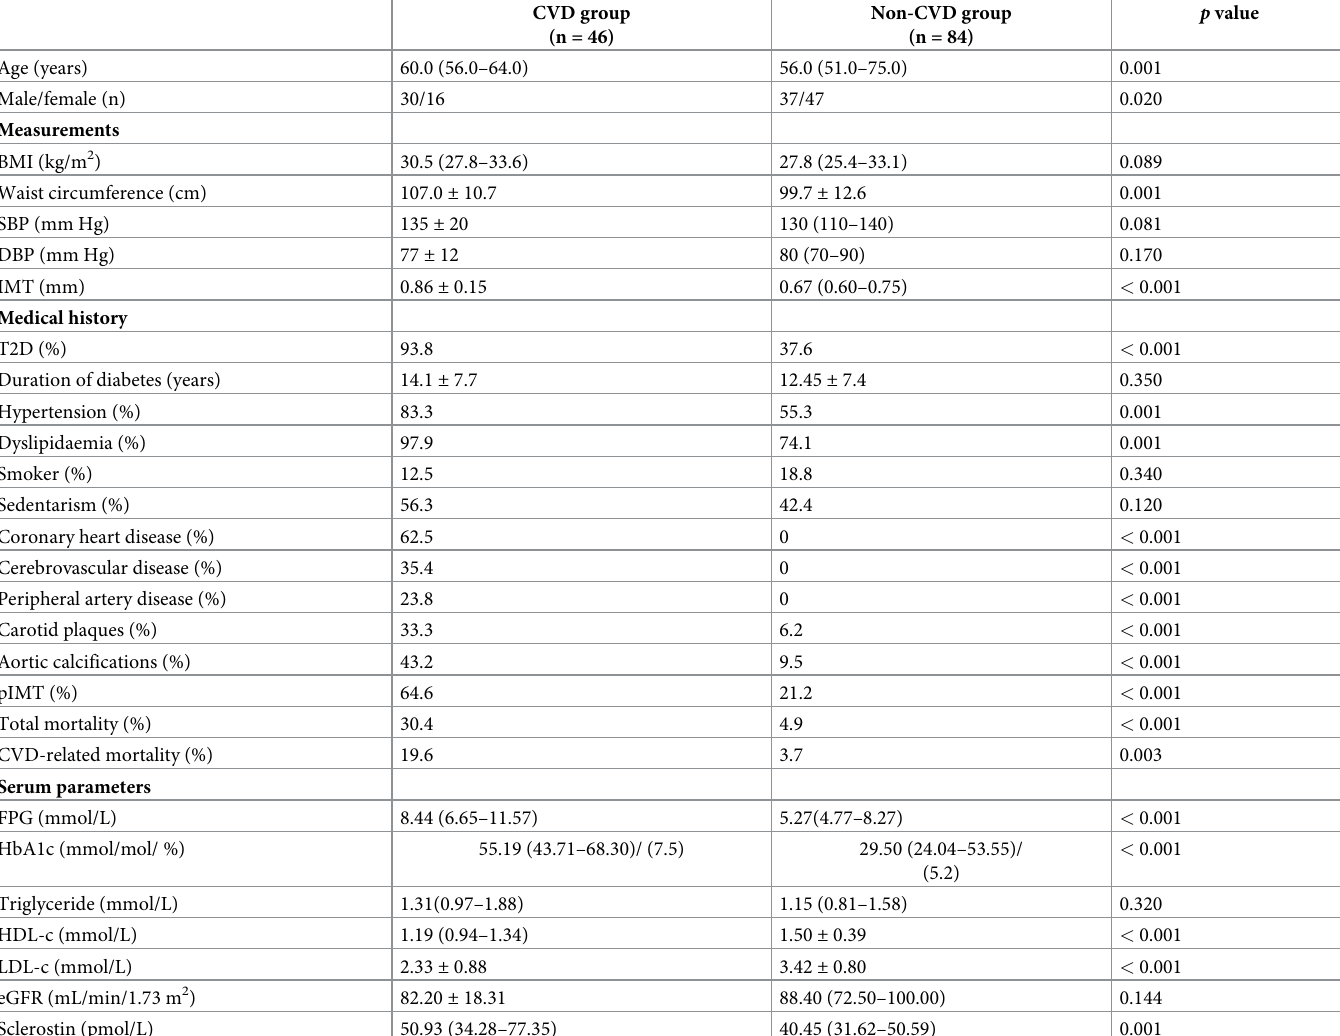
Table 1. Anthropometric and biochemical parameters of the study participants according to the cardiovascular disease status.